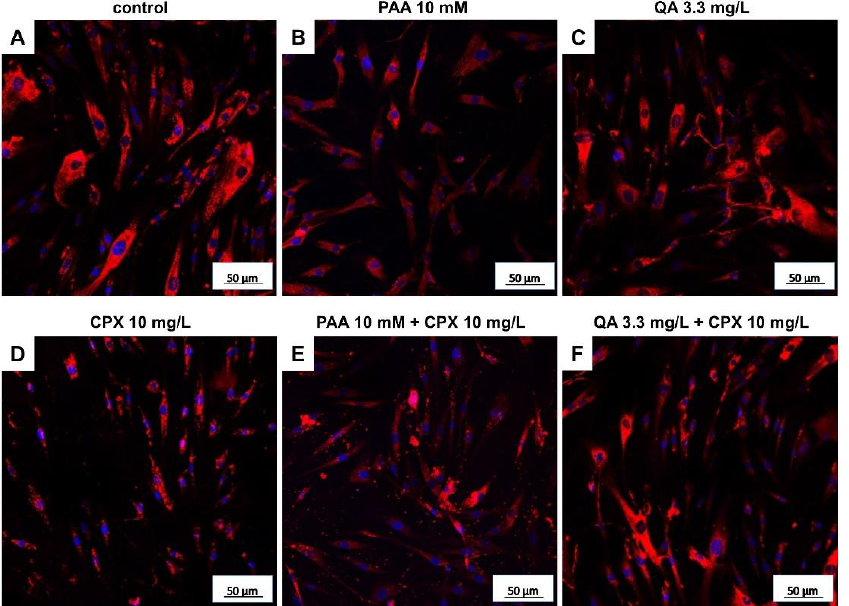
Figure 6. Tenocyte type I collagen expression after 72 h in response to stimulation with CPX alone and with PAA and QA, alone and in combination with CPX. Representative images of collagen type I immunolabeling (red) are shown. Cell nuclei are counterstained in blue using 4′,6′-diamidino-2-phenylindol (DAPI). ( A ) Untreated control, ( B ) PAA 10 mM, ( C ) QA 3.3 mg/L, ( D ) CPX 10 mg/L, ( E )